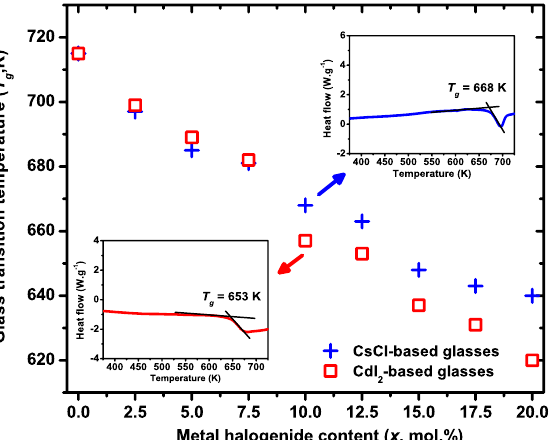
Figure 1. Evolution of T g as a function the metal halide CsCl (blue crosses) or CdI 2 (red squares) content. Inset correspond to the DSC traces of glasses with 10 mol. % of CsCl (blue line) or CdI 2 (red line).